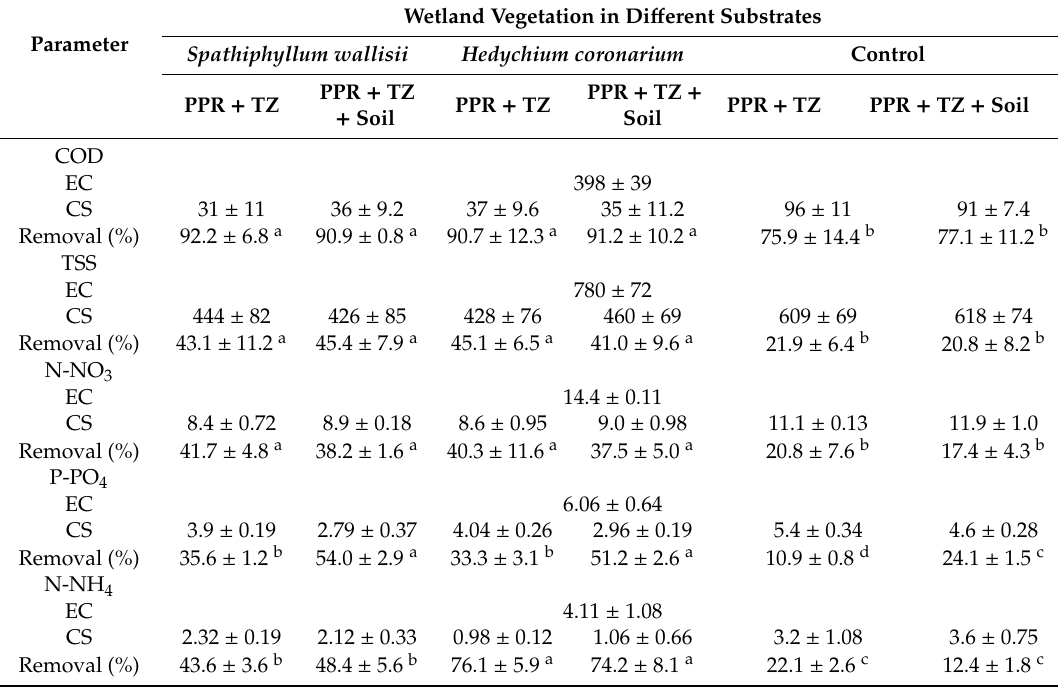
Table 3. Concentrations and removals average contaminants removed in the mesocosms CWs.